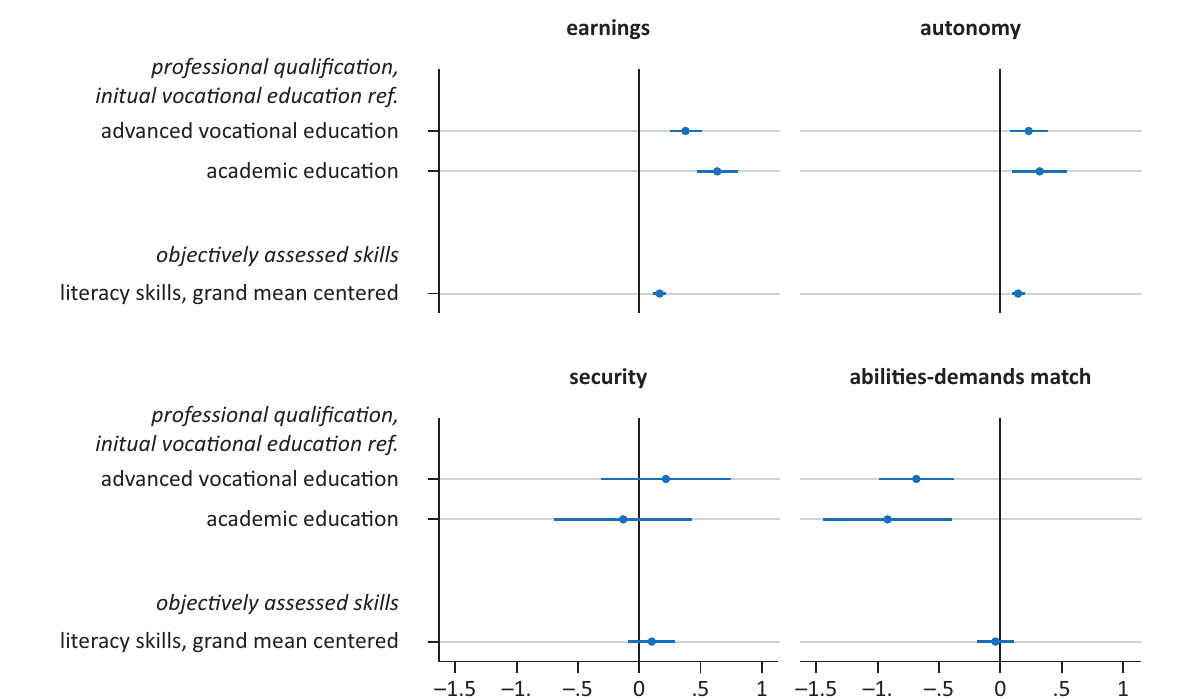
Figure 1. Associations of professional qualification and literacy skills with four indicators of job quality. Notes: PIACC 2012, continuous variables standardized; N(earnings) 2,084, N(autonomy) 2,216, N(security) 2,218, N(abilities-demands match) 2,217; the axis refers to either changes in S.D. (earnings and autonomy) or logits (security and abilities-demands match); controls: gender, migration, school qualification, age, age-squared, firm size, parental